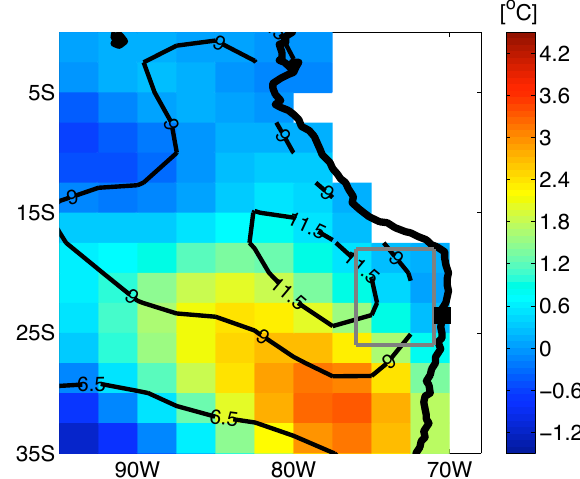
Fig. 9. October-mean θ 850hPa – θ 1000hPa (contours) and MAX-MIN Figure 9. October-mean  –  (contours) and MAX-MIN N d composite N d composite differences in θ 850hPa – θ 1000hPa (color). Arica Bight 850 hPa 1000 hPa domain contoured in grey. differences in  –  (color). Arica Bight domain contoured in grey. 850 hPa 1000 hPa